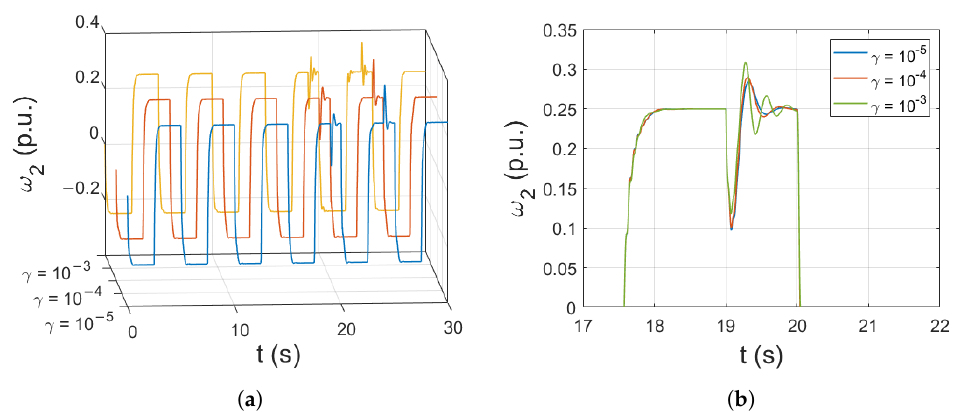
Figure 11. Impact of the center-width-related learning rate γ ( a ), zoom of a selected part of simulation ( b ).